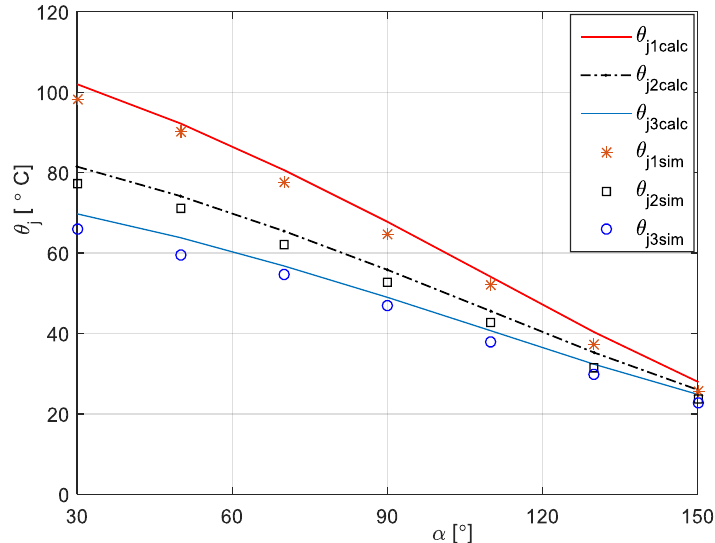
Figure 9. Junction temperature variation vs. firing angle at different air speed values of 1; 3 and 6 m/s ( I = 250 A; R = 3 Ω; L = 30 mH).